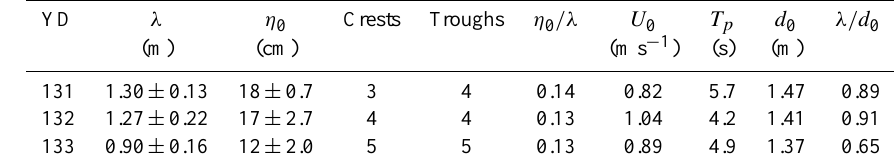
Table 1. Ripple properties and associated wave forcing parameters.